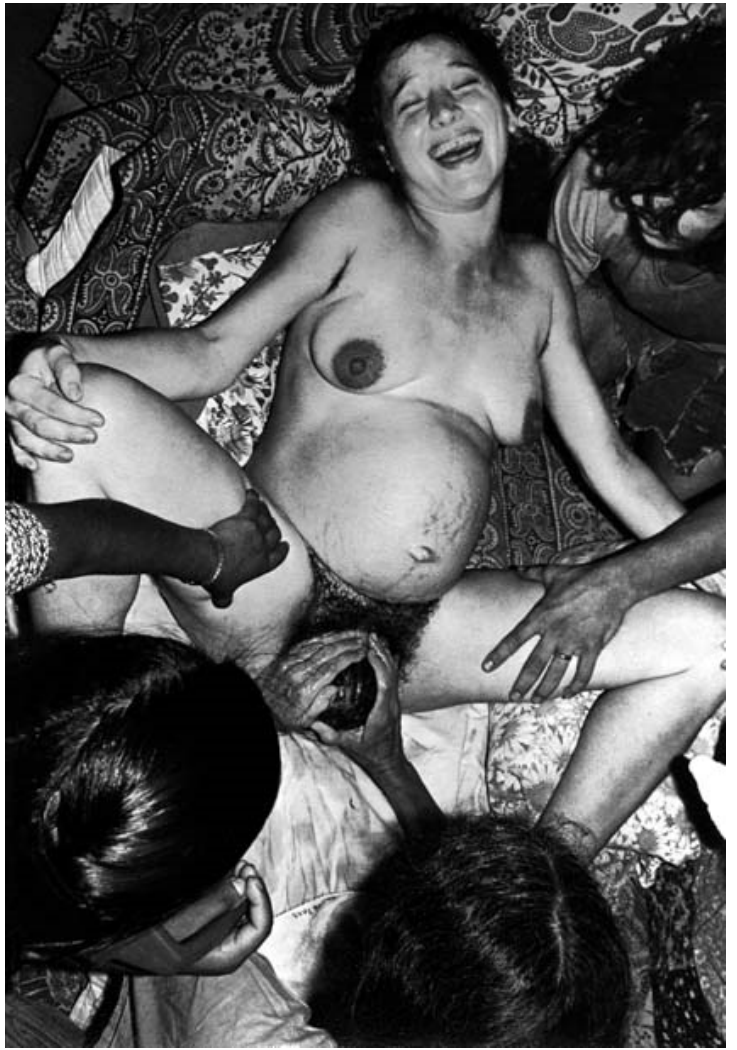
Figure 1: ‘Terese crowning in ecstatic childbirth’ from Ina May's guide to childbirth , Hermione Wiltshire, 2008, black and white photograph, the birthrites collection. Reproduced with the permission of the